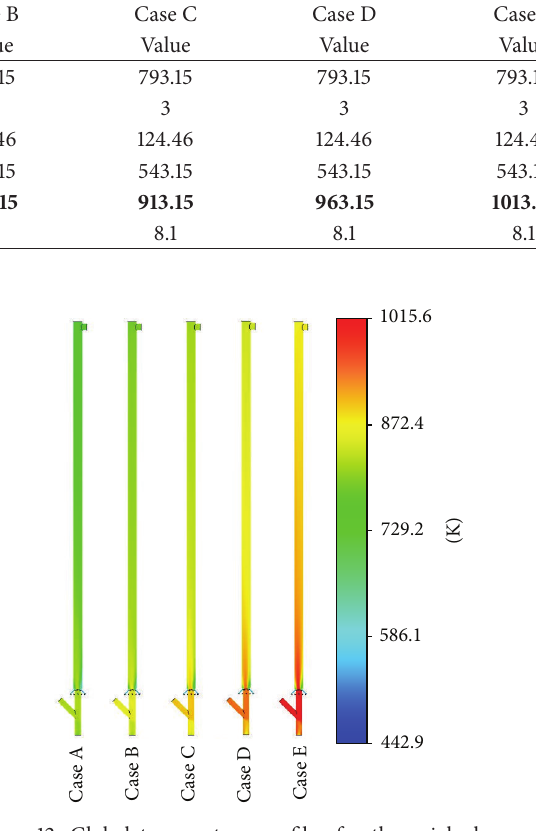
Figure 12: Global temperature profiles for the axial plane with variations in catalyst